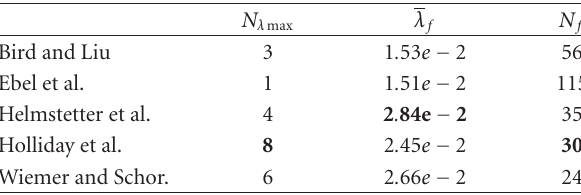
Table 3: Comparisons of the forecasts: Column 1. the number of maximum cell scores N λ max . Column 2: the mean cell scores forecast λ N f . Column 3: the number of earthquakes f predicted by each forecast. The best scores in each category are in bold. N λ